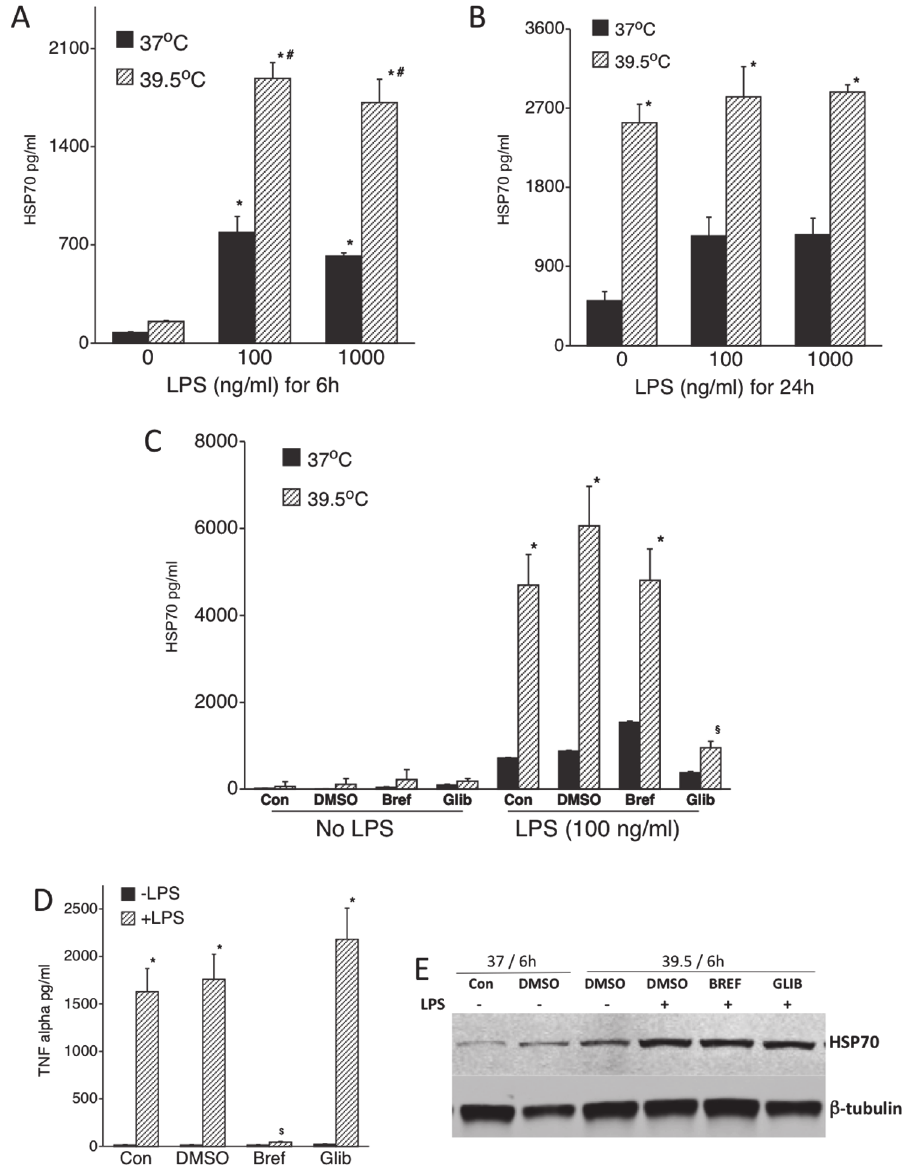
Fig 3. LPS/FRH co-exposure increases release of eHSP70 that is secreted via a non classical protein secretory pathway: A, B. Differentiated THP1 cells were stimulated with 100 ng/ml or 1 μ g/ml of LPS as indicated and incubated either at 37°C or 39.5°C for 6 h (A) or 24h (B). Cell culture supernatants were collected and HSP70 levels measured by ELISA. (C) To analyze the effect of protein secretory pathway inhibitors, cells were treated with 0.1% (v/v) DMSO (vehicle), 5 μ g/ml Brefeldin or 100uM Glibenclamide at 37°C for 1 h, then incubated with or without 100 ng/ml LPS for 6 h at 37°C or 39.5°C. The cell culture supernatants were collected and analyzed for HSP70 by ELISA. (D). The supernatants from the 37°C (with and without LPS) culture supernatants from panel C were analyzed for TNF α by ELISA. (E) A representative of four similar immunoblots of lysates from cells in panel C immunoblotted for inducible HSP72 and β -tubulin. Data presented as mean+SE, n = 4. * , and # denote p < 0.05 vs. LPS-untreated and DMSO+LPS-treated cells,